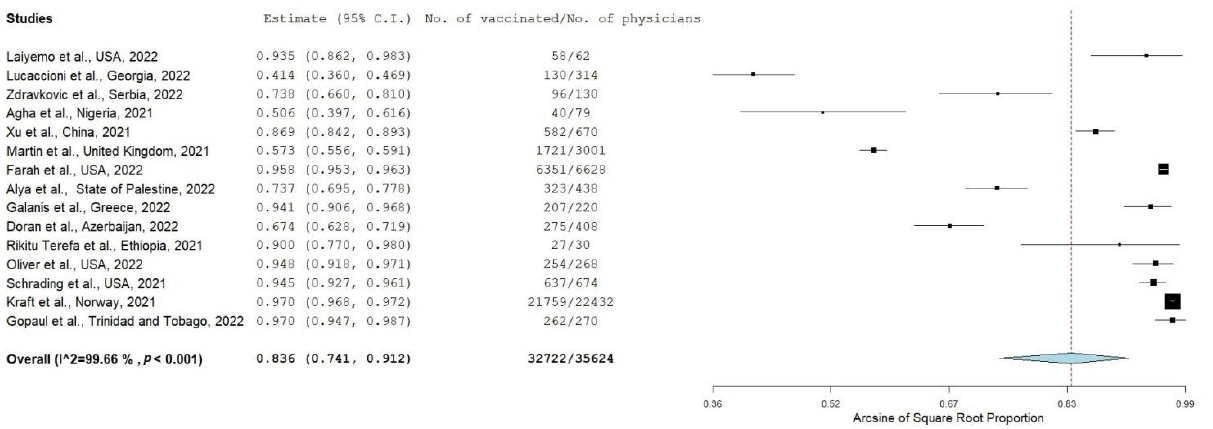
Figure 3. Forest plot of physicians vaccinated against COVID-19.